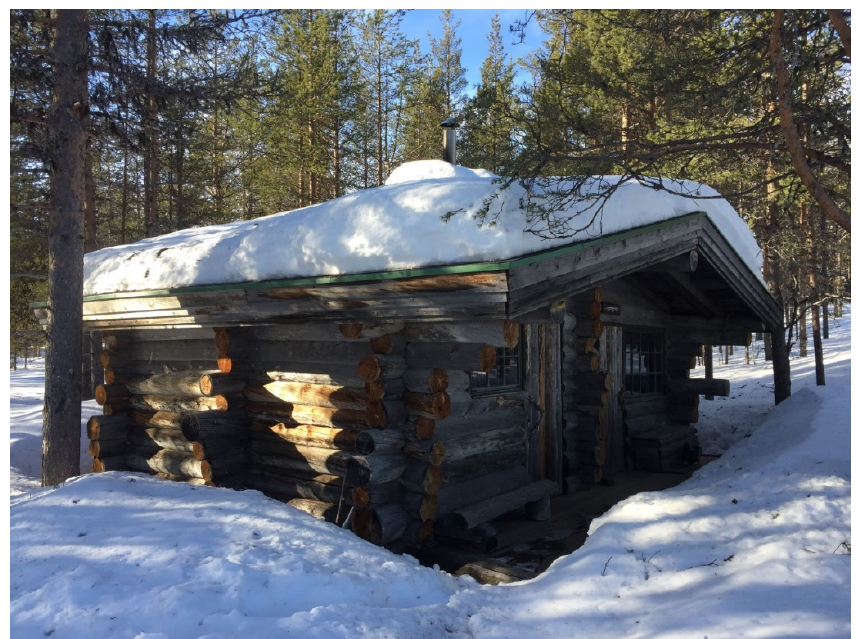
Figure 3. Log cottage example from northern Finland (Photo courtesy of Lotta Häkkänen).